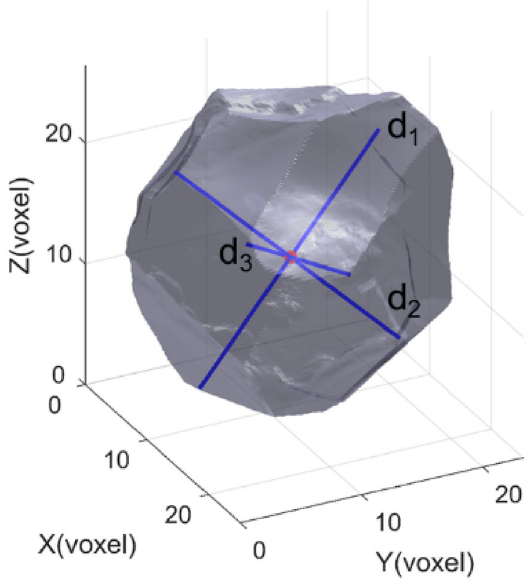
Fig. 6 Length, width, and thickness of a particle determined by principal component analysis